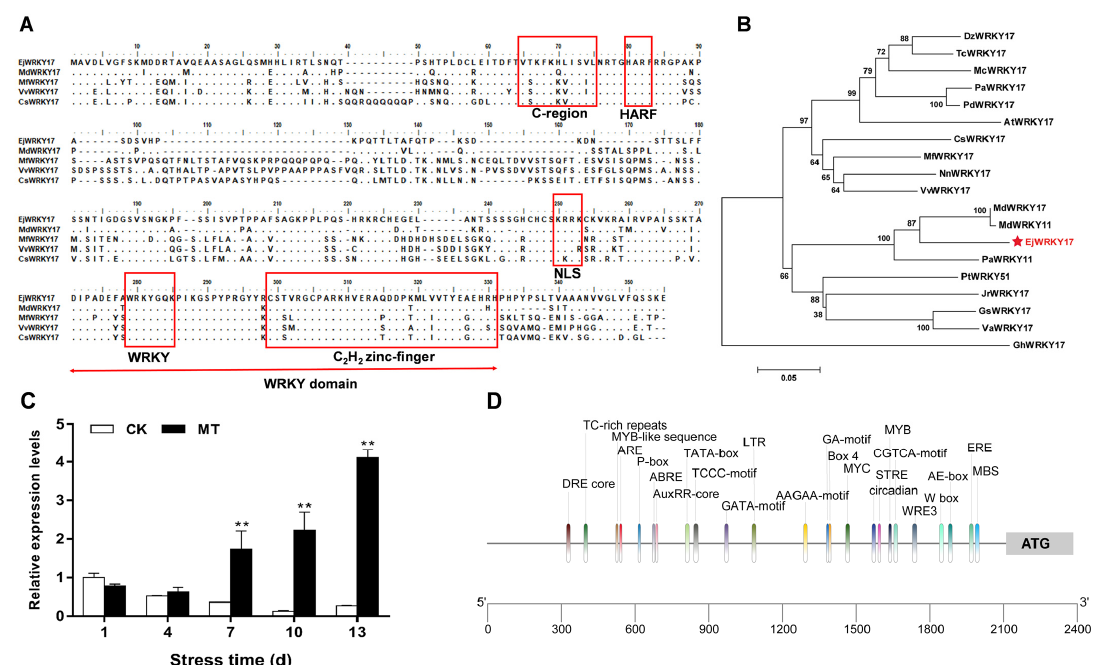
Figure 1. Characterization of EjWRKY17. ( A ) Multiple alignment of amino acid sequences of EjWRKY17 with other WRKY proteins. ( B ) Phylogenetic analysis among EjWRKY17 and WRKY proteins from other plant species. ( C ) Expression levels of EjWRKY17 during drought stress. ( D ) Cis -acting elements in the promoter region of EjWRKY17 gene. The conserved domain or motif was marked by the red line; NLS, nuclear localization signal. Asterisks denote significant differences (as compared with the control group): ** p < 0.01.